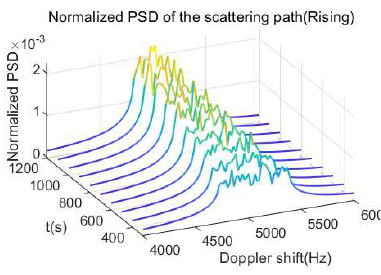
Figure 9. The normalized Doppler PSD (Rising).